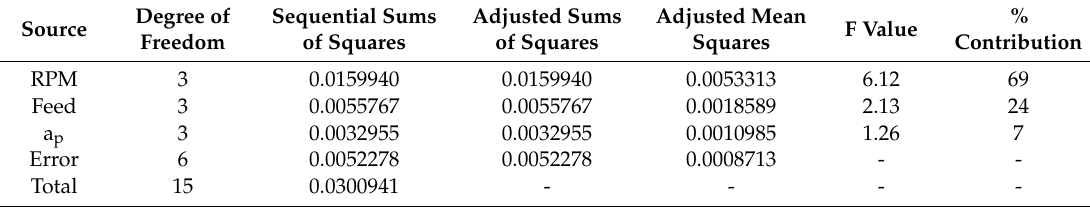
Table 4. Analysis of variance for material removal rate (MRR).